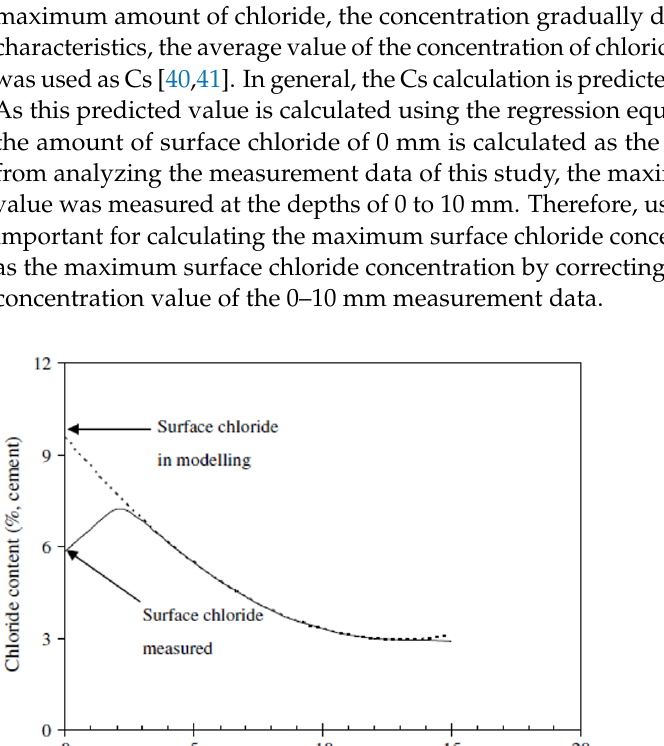
Figure 15. Diffusion coefficient by location (15–25 mm).